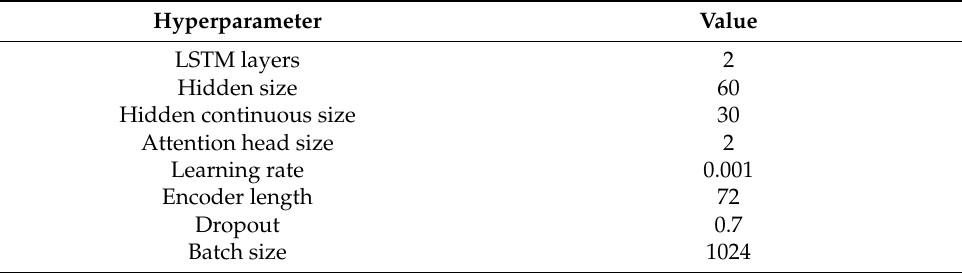
Table 5. Selected hyperparameters for TFT model.